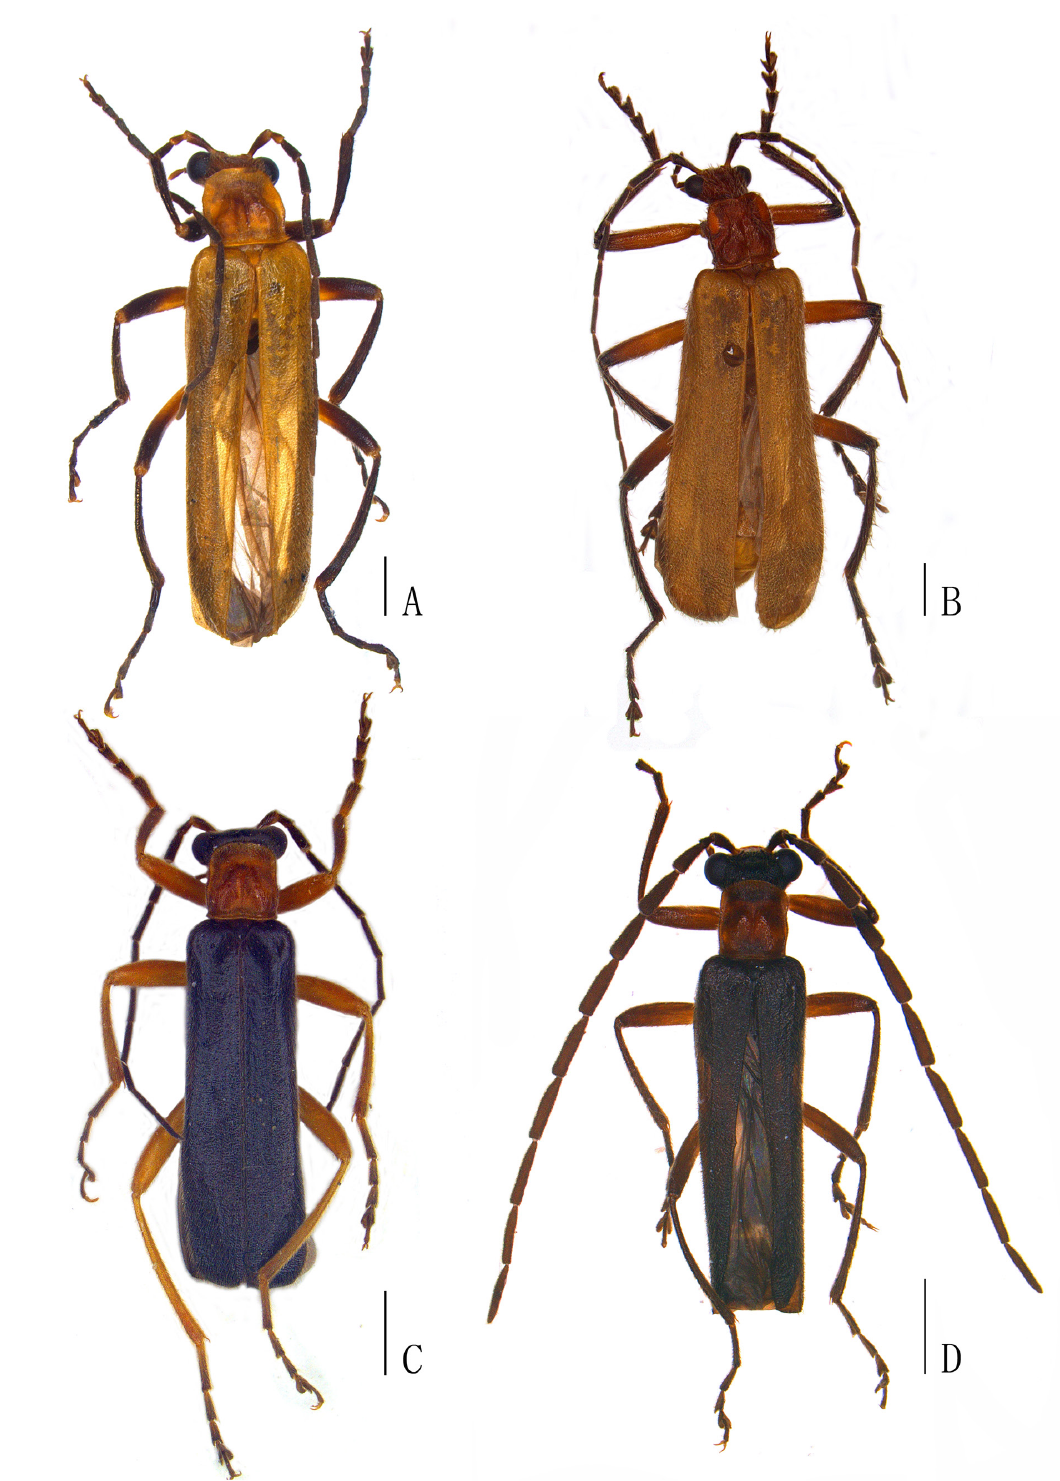
Fig. 2. Male habitus, dorsal view. A . Stenothemus biimpressiceps (Pic, 1930) comb. nov., non- type specimen from Zhejiang (IZAS). B . S. flavus Y. Yang & X. Yang sp. nov., holotype, ♂ (IZAS, IOZ(E)1123159). C . S. limbatipennis (Pic, 1926) stat. rev. et comb. nov., non-type specimen from Zhejiang (MHBU). D . S. longicornis Y. Yang & H. Liu sp. nov., holotype, ♂ (MHBU, HBU(E)410001). Scale bars: 1.0